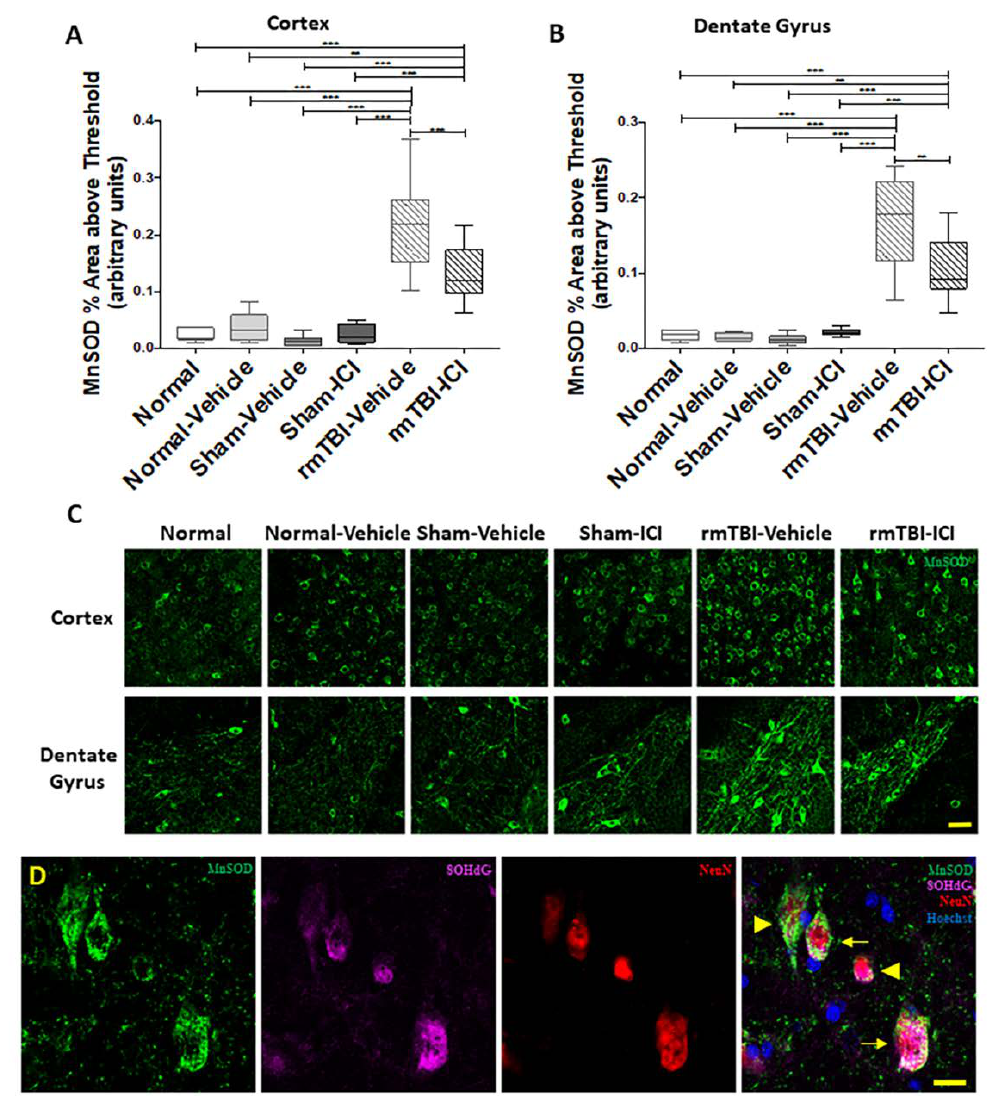
Figure 5. Manganese-dependent superoxide dismutase (MnSOD) immunoreactivity in the brain on day 11 following mTBI on days 1 and 2. Percentage area above threshold of MnSOD immunoreactivities are shown as median, interquartile range, and range in the ( A ) middle cortex and the ( B ) hilus of the dentate gyrus. ( C ) Representative images of MnSOD immunofluorescence (green) indicating oxidative stress; scale bar = 100 µ m. MnSOD immunoreactivity was not observed in the corpus callosum. ( D ) High-magnification (1000 × ) image of MnSOD (green), 8OHdG (magenta), and NeuN (red) immunofluorescence at the middle cortex. Merged image demonstrates co-localisation (arrow) of MnSOD, 8OHdG, and NeuN with Hoechst (blue), or lack or co-localisation of MnSOD with 8OHdG (arrowheads); scale bar = 20 µ m. ** p < 0.01, *** p < 0.001, one-way analysis of variance with Bonferroni post-hoc comparisons.